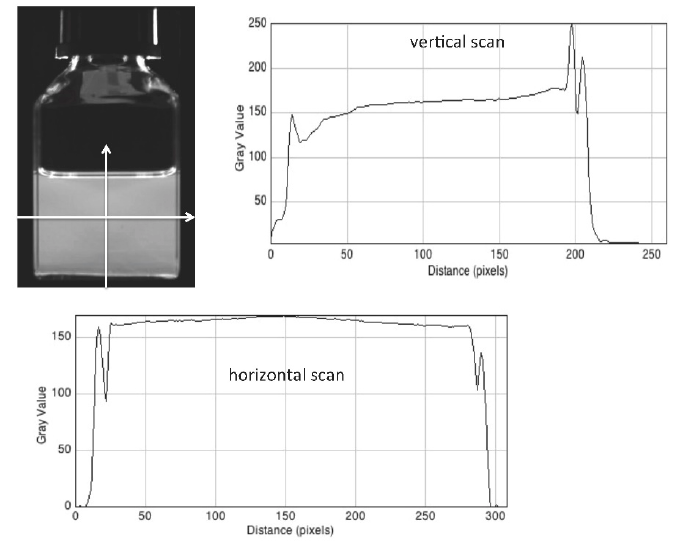
Figure 7. A fluorescence image of a 40 mm square cell containing 30 mm of a dilute liquid solution of diphenyl anthracene with vertical and horizontal intensity profiles made using ImageJ at 6.6 pixels per mm.